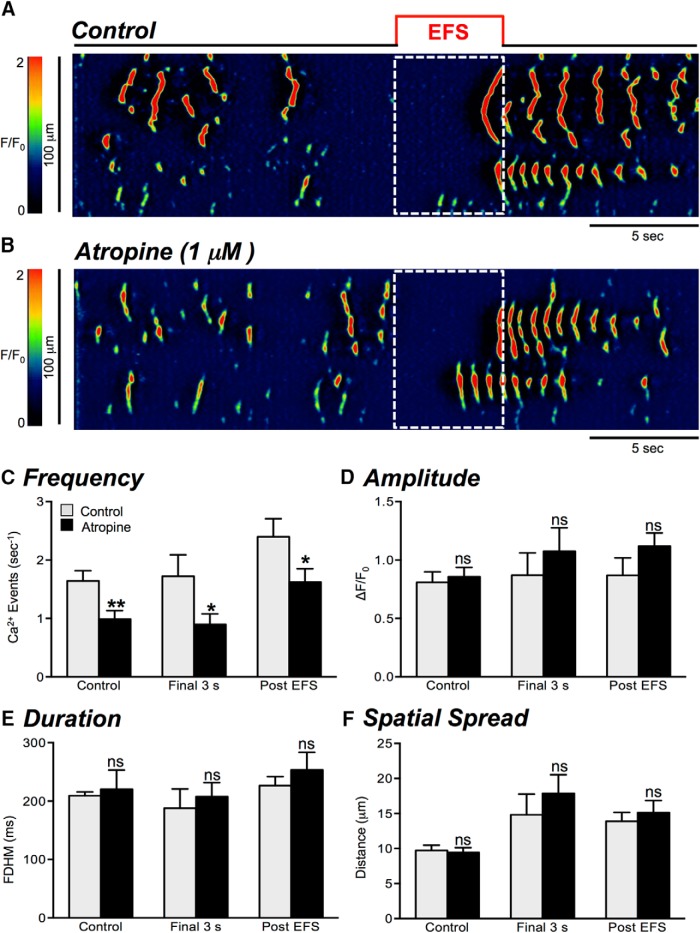
Effects of atropine on Ca2+ transient responses to EFS. A, B, Representative ST maps showing the effects of atropine (1 μM) on Ca2+ transients in ICC-DMP in response to nerve stimulation (EFS; 10 Hz; 5 s; indicated by the red line and dotted white box in ST maps). C–F, Summary data showing the effects of atropine (1 μM) on Ca2+ transients during EFS: frequency (C), amplitude (D), duration (E), and spatial spread (F) in ICC-DMP during control conditions, during the excitatory period of EFS (final 3 s), and during the post-EFS period (5 s), n = 5, c = 21; ns = p > 0.05, *p < 0.05, **p < 0.01.